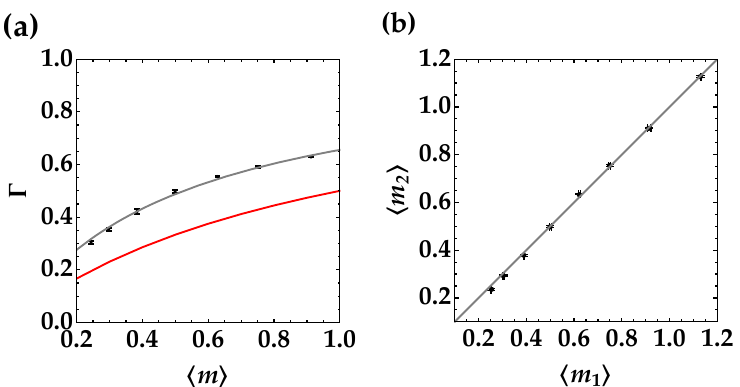
Figure 7. ( a ) Cross-correlation coefficient Γ as a function of the mean number of detected photons obtained as the average betwen the two BS outputs. Black dots and error bars: experimental data; red curve: theoretical model in the case of a single-mode thermal state; gray curve: theoretical fitting function according to Equation (10), in which µ f = 1.22, while µ s is the only fitting parameter. The obtained value is: µ s = 1.69 ± 0.06. ( b ) Black dots and error bars: mean number of photons detected at one BS output as a function of the mean number of photons detected at the other output. Gray line: diagonal y = x